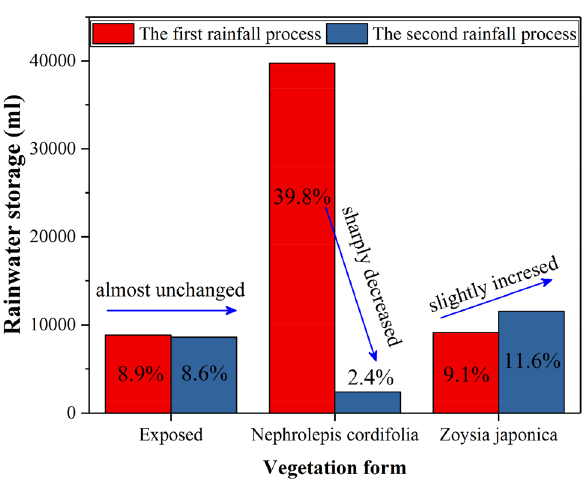
Figure 8. Comparison of the water storage capacity of the different vegetation-covered